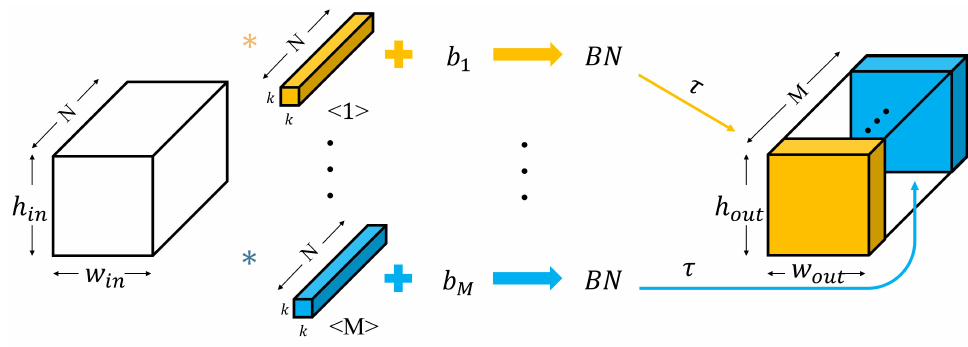
Figure 1. Process of the convolution layer.